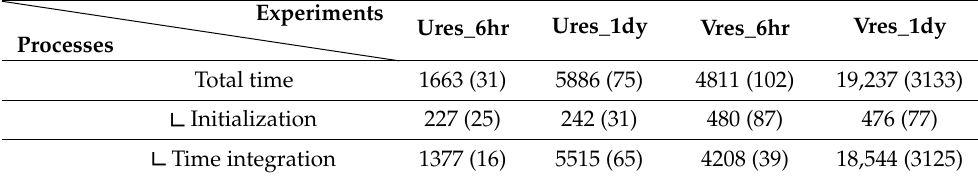
Table 4. Averaged use of computational time (unit: s) for one cycle of the experiments with 1024 cores of KNL node of KISTI NURION. Numbers in parentheses indicate the standard deviations. Processes